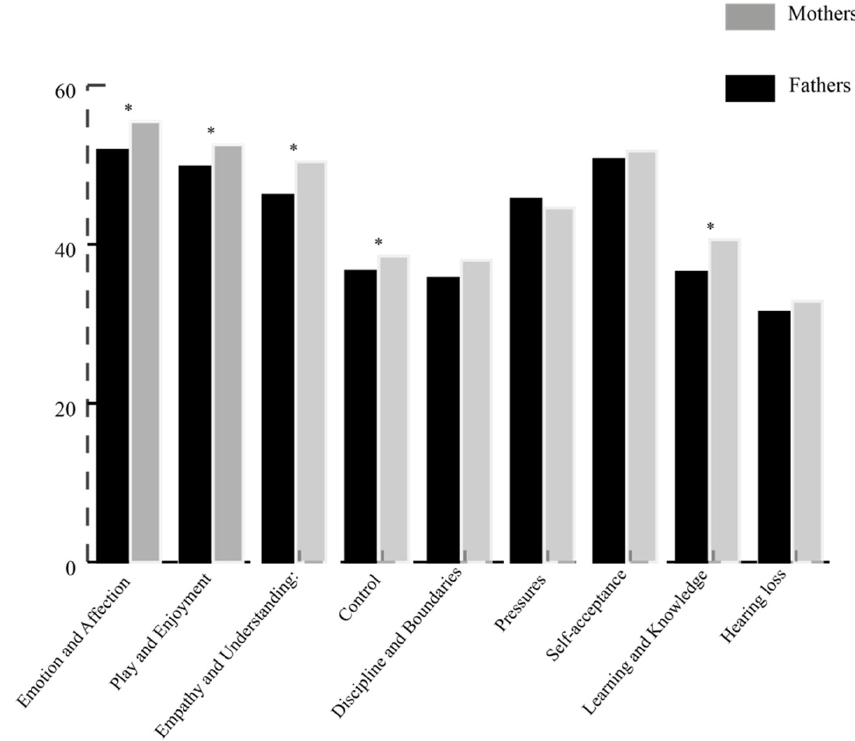
Figure 1. Mean scores of fathers’ and mothers’ parental self-efficacy subscales. * p < 0.05.